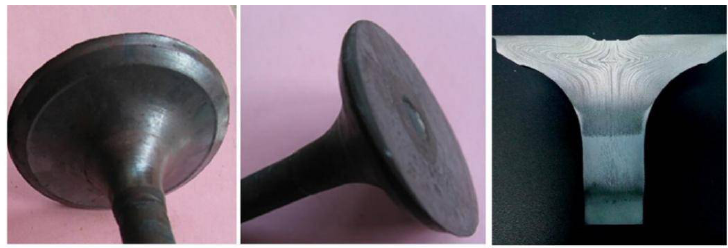
Figure 8. Manufacturing valves using the forging machine.